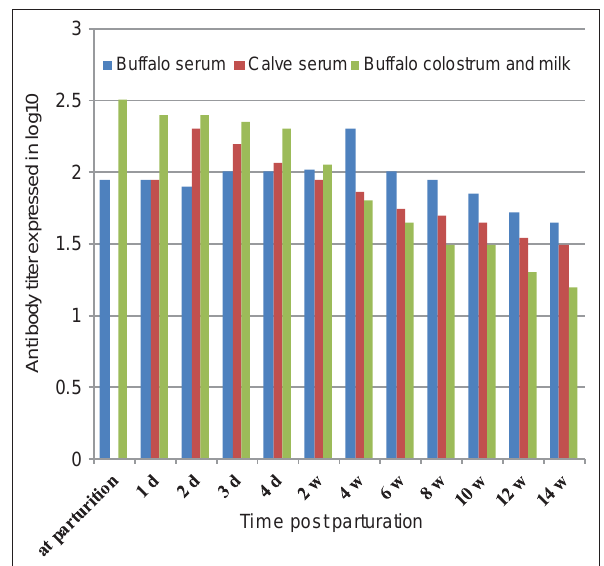
Figure-4: Comparison between the mean antibody titer of serum and colostrum of naturally infected buffalo, their calves by serum neutralization test.